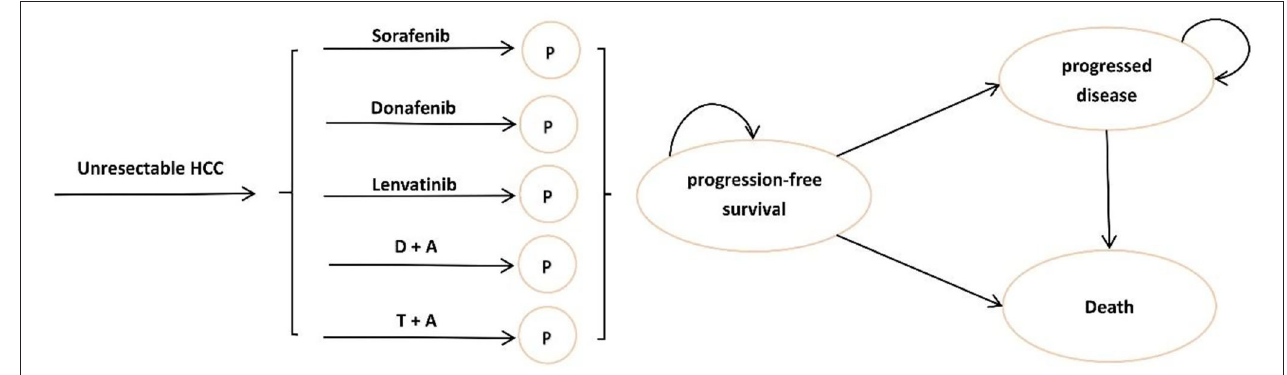
FIGURE 1 | Model structure of a decision tree combining the partitioned survival model. (HCC, hepatocellular carcinoma; P, progression-free survival; D + A, sintilimab plus bevacizumab; T + A, atezolizumab plus bevacizumab).